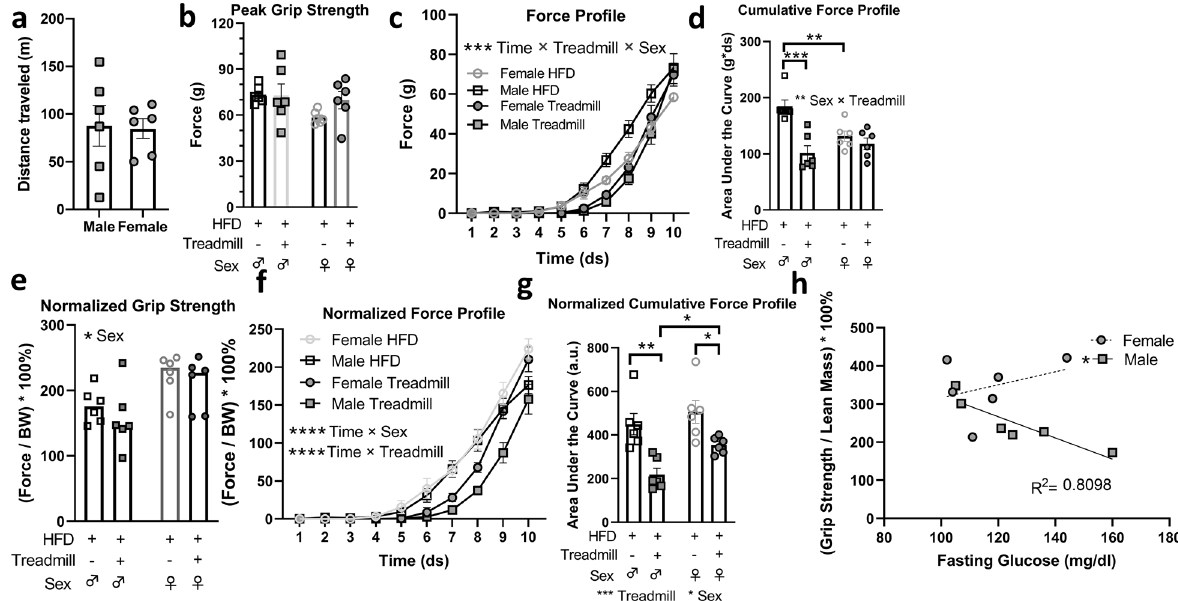
Figure 6. Acute recovery from aerobic exercise reduces force profile in HFD male mice. ( a , b ) Distance travelled during a treadmill fatigue test, and grip strength following 30 min recovery from treadmill exertion, are similar between sexes. ( c ) Force profile is selectively reduced in males following recovery from treadmill exposure (***p < 0.001, time × treadmill × sex interaction, Tukey’s post-hoc multiple comparison, three-way, repeated measures ANOVA; n = 6/group). ( d ) Cumulative force profile is selectively reduced in males during acute recovery (**p < 0.01, sex × treadmill interaction, ***p < 0.001, two-way repeated measures ANOVA, Sidak post-hoc test). ( e ) Body-weight normalized peak grip strength is not influenced by treadmill recovery. ( f ) Force profile normalized to body weight are altered by both sex and treadmill exposure (****p < 0.0001, time × sex and time × treadmill, Tukey’s post-hoc multiple comparison, three-way, repeated measures ANOVA). ( g ) Females are moderately resilient to treadmill exposure mediated-reductions in cumulative force profile normalized to body weight (*p < 0.05, ***p < 0.01, two-way repeated measures ANOVA, Sidak post-hoc test). ( h ) Fasting glucose levels and grip strength normalized to lean mass are negatively correlated following treadmill fatigue in male mice, but not female mice (*p < 0.05, coefficient of correlation = 0.8098).